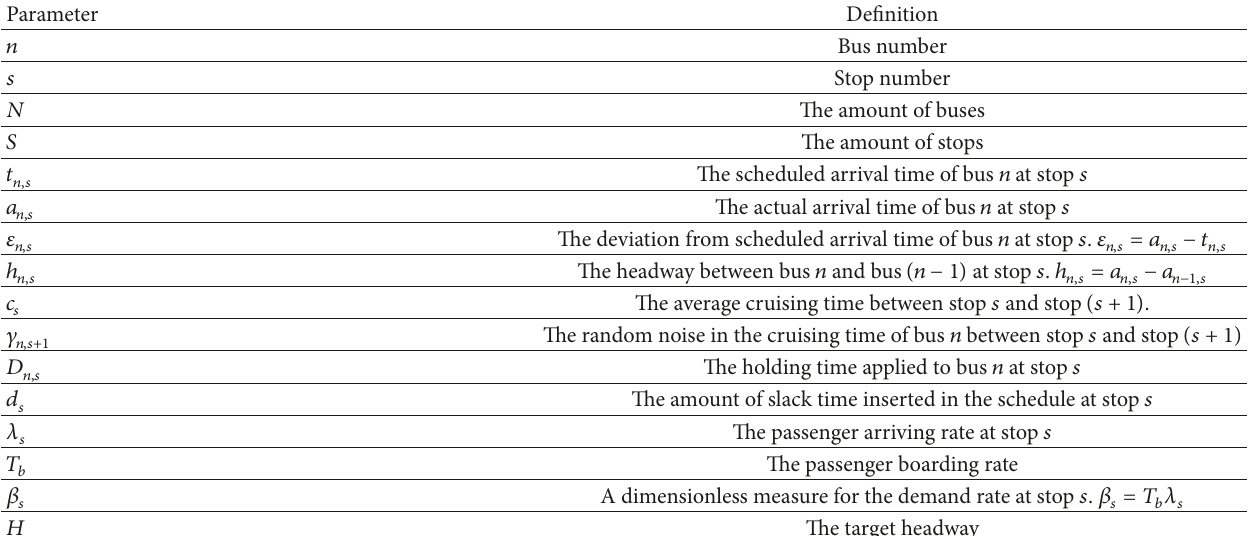
Table 2: Summary of primary